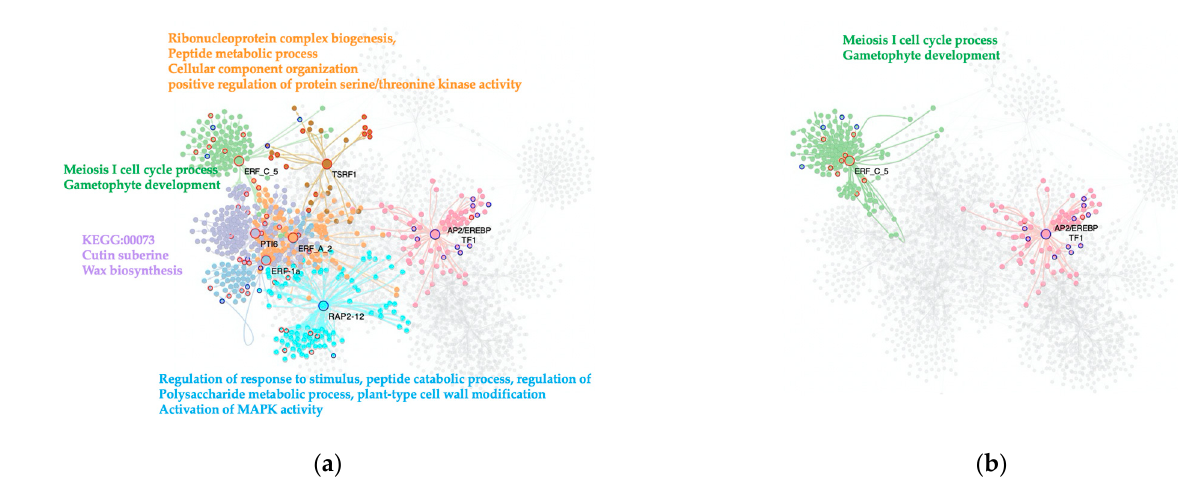
Figure 4. Interactome of the ERFs MTRs in the experimental condition’s comparisons. ( a ) C. vs. S23 condition, ( b ): M. vs. S23 condition. Each node represents a gene, the edges between nodes represent regulatory interactions between genes. The big, highlighted nodes with a specific color represent ERF-MTRs, while nodes of the same color surrounding these represent target genes regulated by an MTR. The most differentially expressed genes in each regulon have colored perimeters, blue for downregulation, red for upregulation. Enriched biological processes of each regulon are presented in the same color as the regulon. In the comparison C. vs. S23 ERF-MTRs are ERF_A_2 (orange), AP2/EREBP TF1 (pink), ERF_C_5 (green), PTI6 (purple), RAP2-12 (light blue), ERF-1a (blue) and TSR1 (brown). Meanwhile, in the comparison, M. vs. S23 ERF-MTRs are AP2/EREBP TF1 (pink) and ERF_C_5 (green).